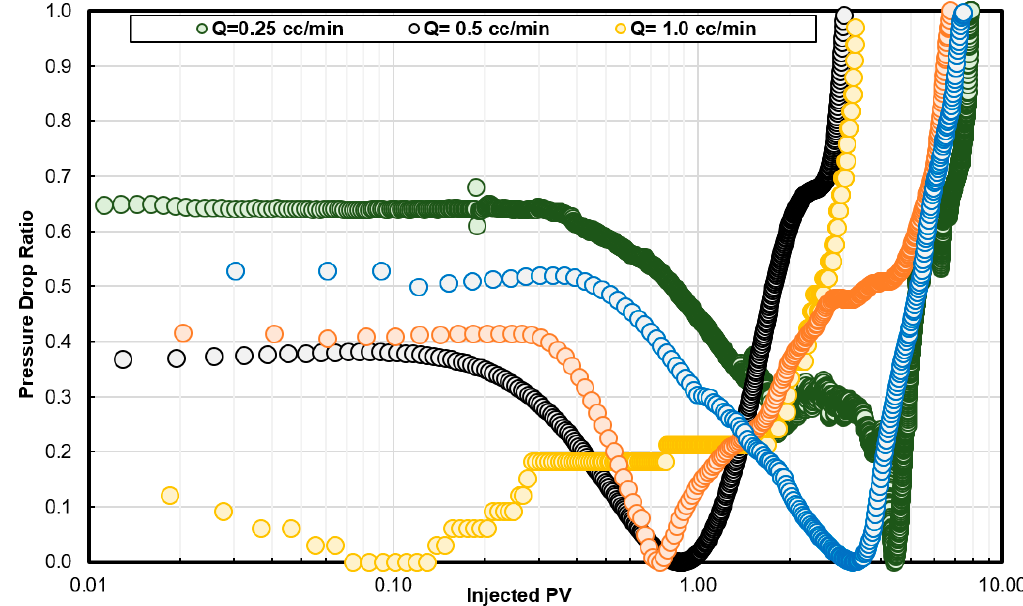
Figure 18. Normalized pressure drop as a function of injected pore volumes during injection of 20 wt% GLDA/SW (pH = 3.8) at 250 °F.